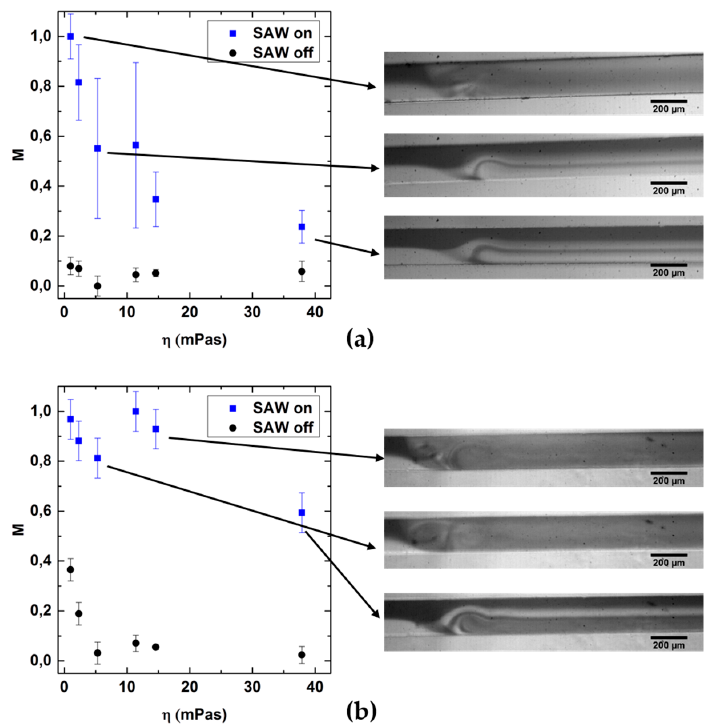
Figure 5. Mixing quality as a function of the viscosity for a constant flow rate of ( a ) F = 0.2 mL/h; and ( b ) F = 0.02 mL/h. Insets: Typical micrographs of the mixing area. The data point and error bars represent the mean and the standard deviation respectively, of at least three experiments.